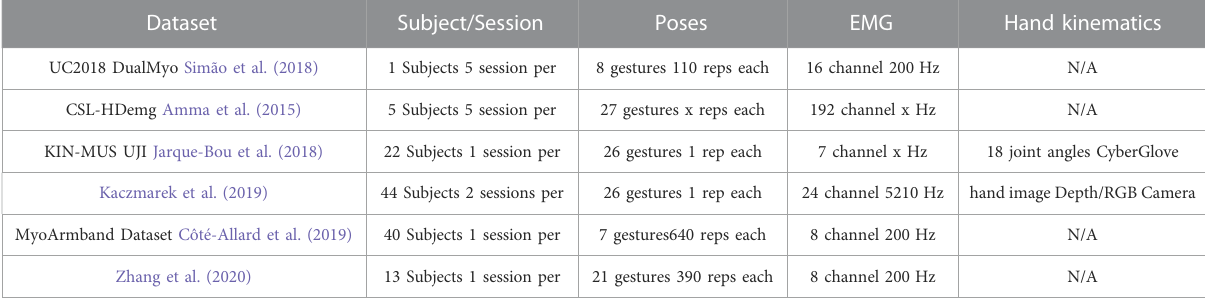
TABLE 1List and details of some publicly available datasets. Each datasets contains value in a speci fi c application, and the variation between datasets can be seen through the parameters